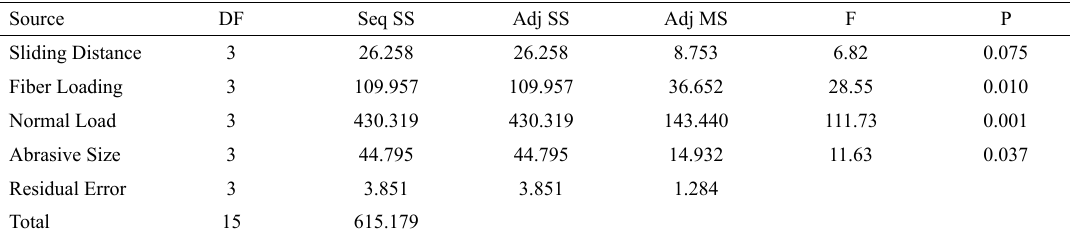
Table 7. ANOVA for specific wear rate of benzoyl chloride treated jute fiber–epoxy composites